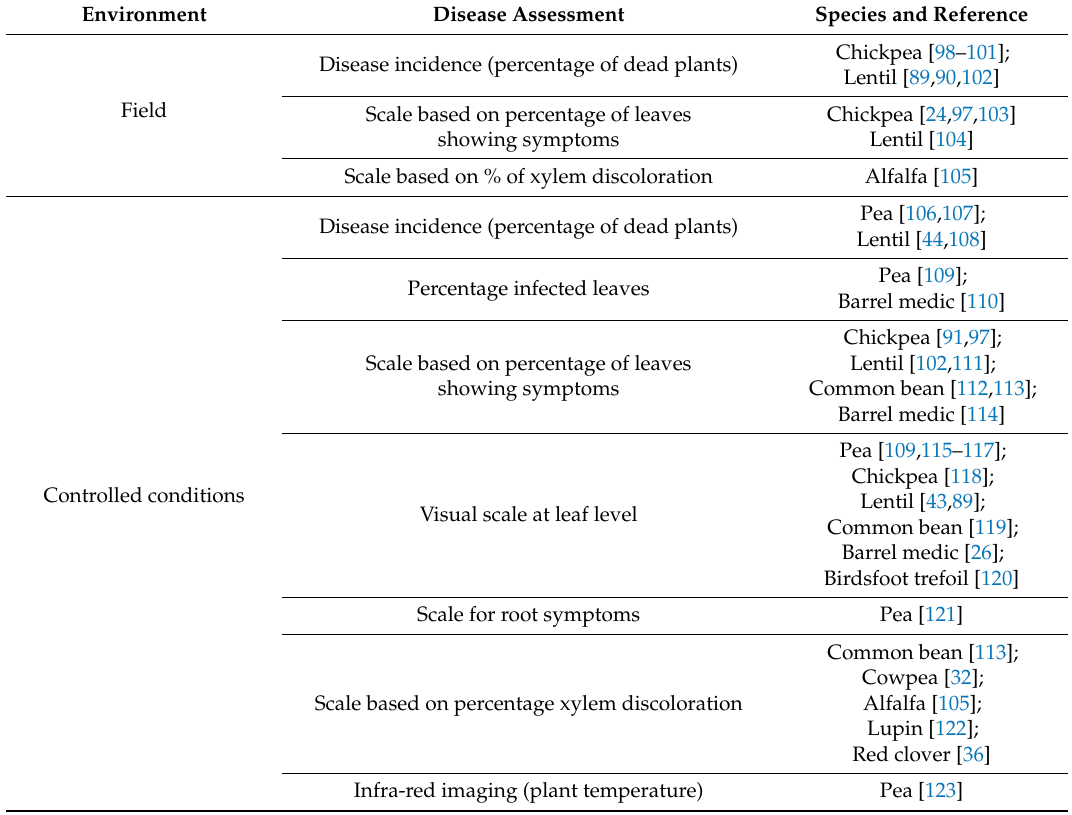
Table 2. Mass screening methods used for Fusarium wilt symptoms evaluation in di ff erent legume